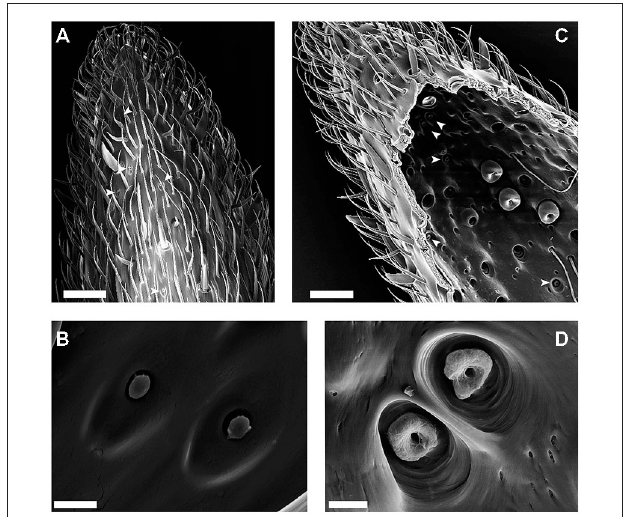
FIGURE 1 | Scanning electron microscopy (SEM)-images of the external and internal cuticular morphology of the S. coelocapitulum. (A) Overview of the distal part of the ventral-lateral side of the 10th antennal segment. The external morphology of the S. coelocapitulum is characterized by an oval depression with a central, mushroom-like protrusion (arrowheads). (B) Close-up of a pair of S. coelocapitula. (C,D) Images of the internal side of the antennal cuticle after tissue removal. (C) Overview of the internal cuticular structures of the distal end of the antennal tip. The prominent pits of the S. coeloconica are visible as a cluster on the ventral-lateral side of the antenna. The smaller cuticular pits (arrowheads) are the S. coelocapitula. (D) Close-up of the base of the pit and peg with an irregular, donut-like surface. Scale in (A,C) : 20 µ m. Scale in (B,D) : 2 µ m.